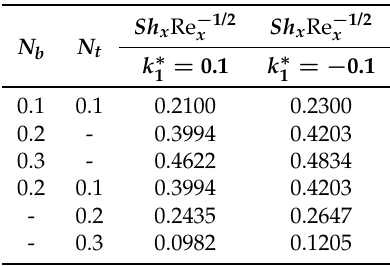
Table 4. Local Sherwood number for various estimations of viscoelastic, Brownian motion and thermophoresis parameters when Sc = Pr = 1.0 and M =